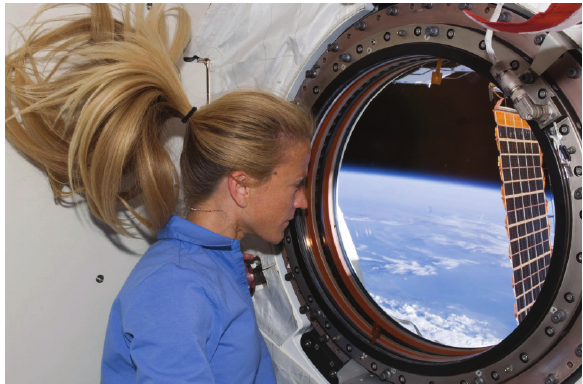
Figure 1: Astronaut Karen Nyberg looking at the blue planet while on board the International Space